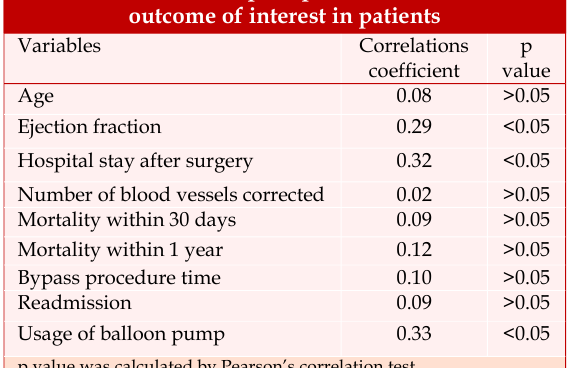
Clinical outcome among the patients with